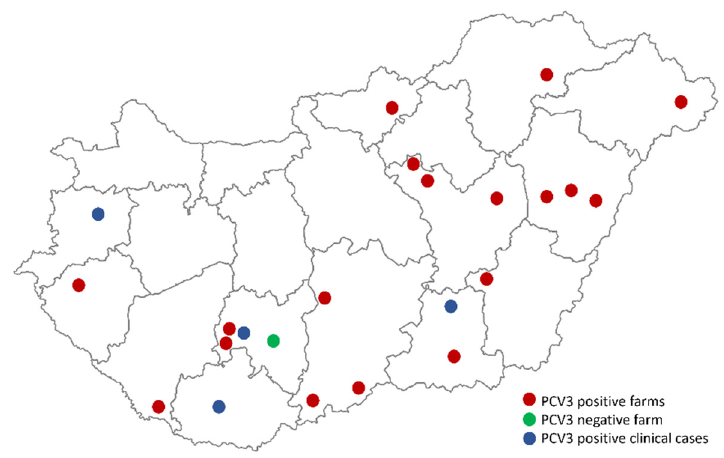
Figure 1. Map of Hungary showing the geographic location of the sampled farms (red/green) and the origin of PCV3-positive cases (blue) used for genome sequencing. Table 1. Summary of the examined Hungarian farms, sample types and sample sizes. The number and proportion of the PCV3-positive samples are also included in the table. The grey cells correspond to sample types that were not